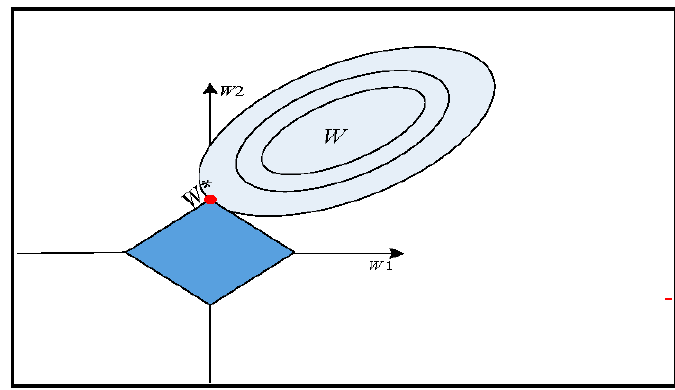
Figure 3. Estimation picture for the ℓ 1-norm regularization (Lasso).